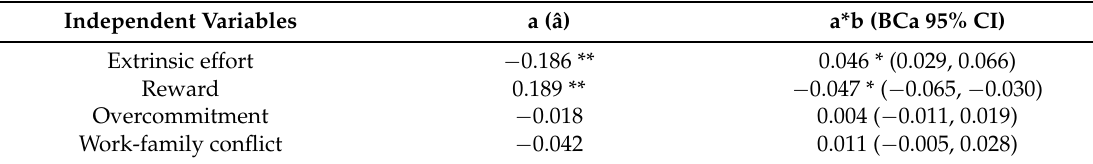
Table 4. Asymptotic and resampling regression analysis results with PsyCap as mediator ( n = 1239). Independent